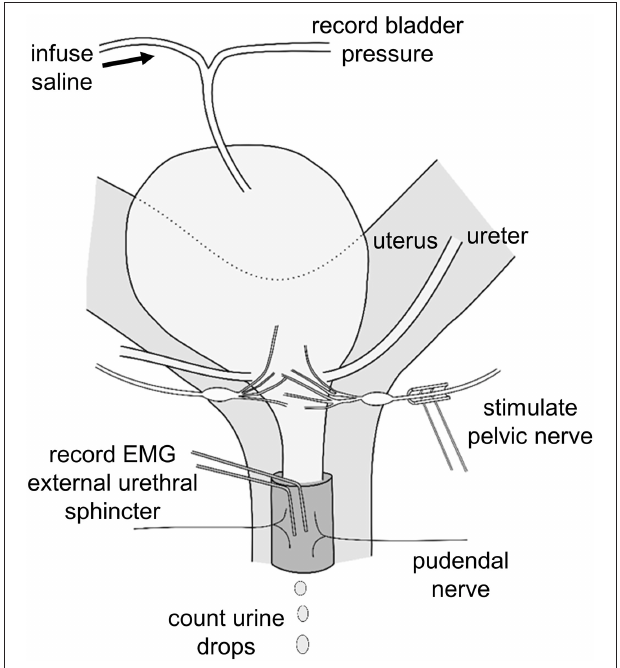
FIGURE 1 | Schematic representation of location of stimulation and recording electrodes on pelvic nerve and external urethral sphincter and position of catheter in bladder used to record bladder pressure and infuse